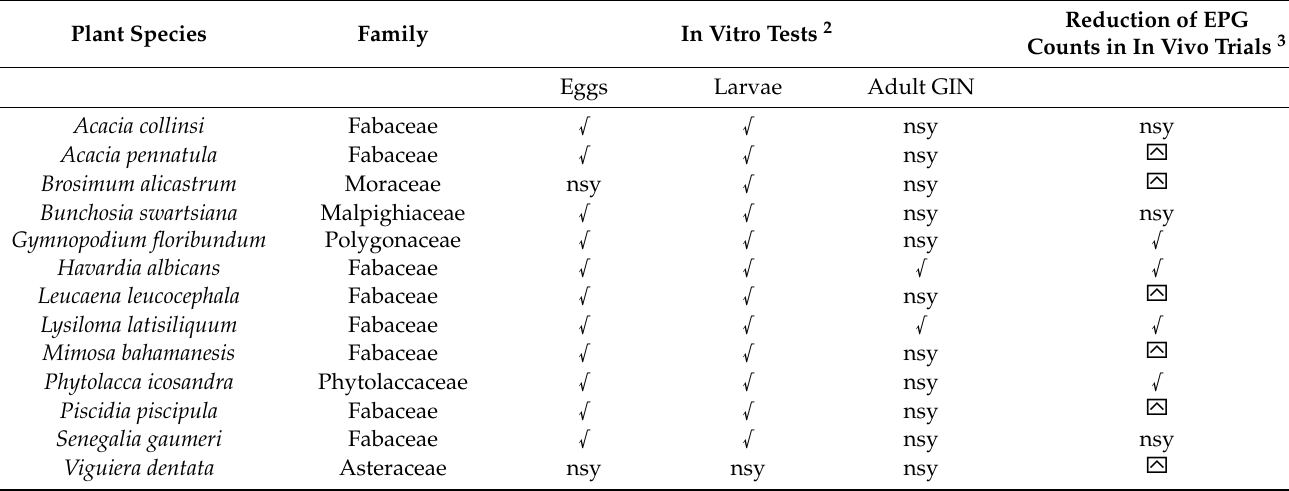
Table 4. Summary of the anthelmintic effect of the low deciduous forest plants species against different phases of gastro- intestinal nematodes’ biological cycles 1 .